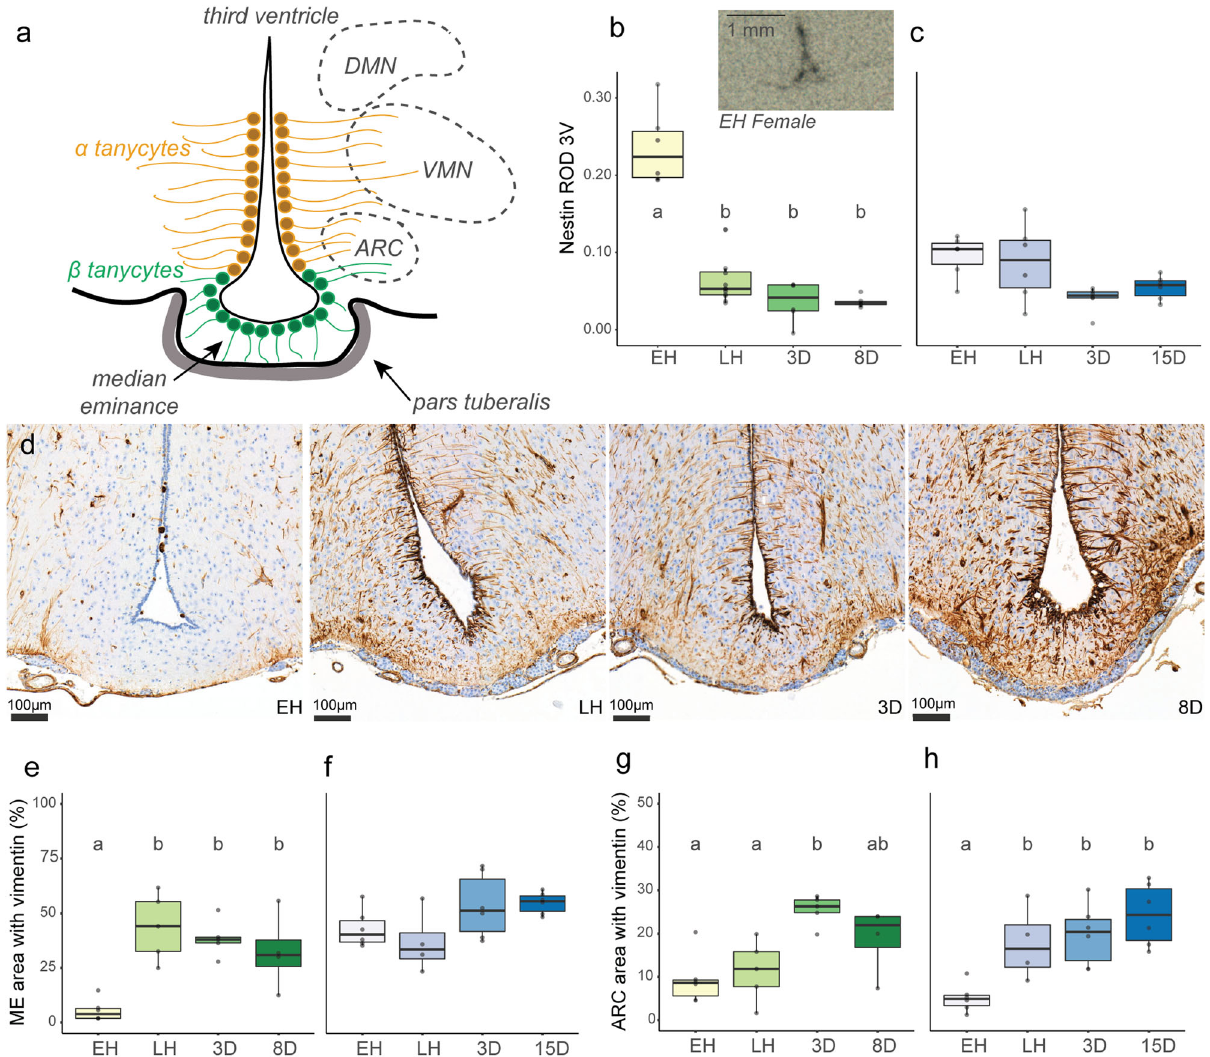
Fig. 3 Cellular re-modeling of hypothalamic tanycytes during hibernation. a Schematic representing distribution of α (orange) and β (green) tanycytic sub-types along the third ventricle of the hypothalamus. Dashed lines indicate the approximate location of adjacent nuclei (ARC: arcuate nucleus; VMN: ventromedial nucleus; DMN: dorsomedial nucleus). Expression of nestin mRNA along the third ventricle of the hypothalamus in female ( b ) and male ( c ) arctic ground squirrels as quanti fi ed by relative optical density (ROD) of radio-labeled probes during in-situ hybridization. Inset in panel B shows representative nestin staining in early hibernation females and scale bars are 1 mm. d Immunohistochemistry (IHC) of vimentin protein across sampling timepoints in female arctic ground squirrels (one individual per timepoint). Panels e – h represent quantitative scoring of vimentin in the ME ( e , f ) and ARC ( g , h ) in females ( e , g ) and males ( f , h ). For all boxplots, signi fi cantly different pairwise comparisons with linear-mixed effects modeling are indicated by lower-case letters ( p < 0.05). Colored shading represent the different sampling groups, the center line in the box plot represents the median, box boundaries represent the 25th and 75th percentiles, and error bars represent the 25th and 75th percentiles ± 1.5 times the interquartile range. For sample sizes, see “ Methods ” . See also Supplementary Figs. S1 –